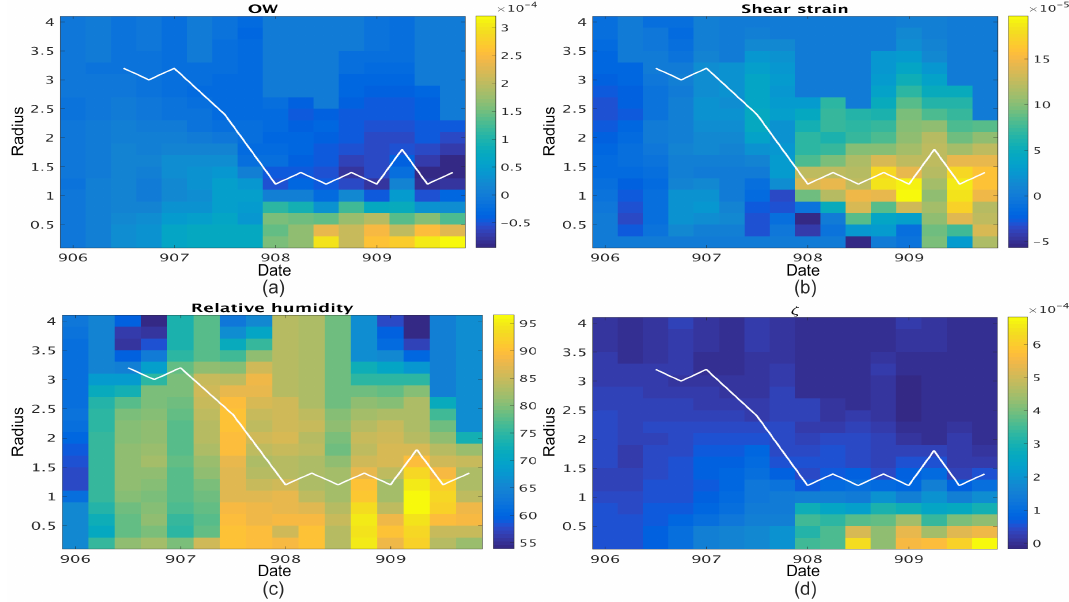
Figure 8. The radial (degrees) profiles of OW (s − 2 ), shear strain (s − 1 ), relative humidity (%), and vorticity (s − 1 ) from the ECMWF data are shown in panels (a) – (d) , respectively, from 06:00 on 6 September to 18:00UTC on 9 September. The radial location of the shear sheath is shown in white.